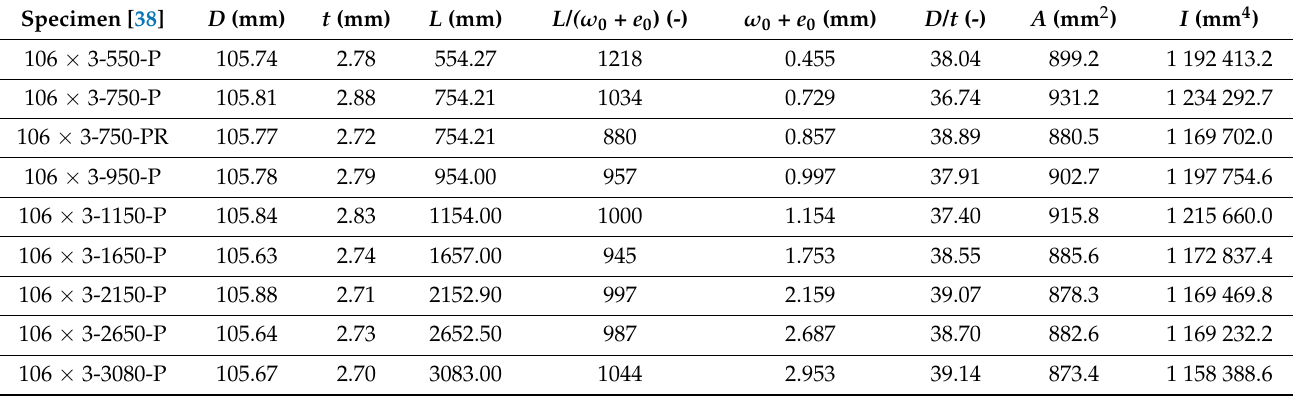
Table 3. Measured and calculated geometric properties of the cross-section set 106 × 3 CHS (circular hollow section) pin-ended columns (austenitic steel).